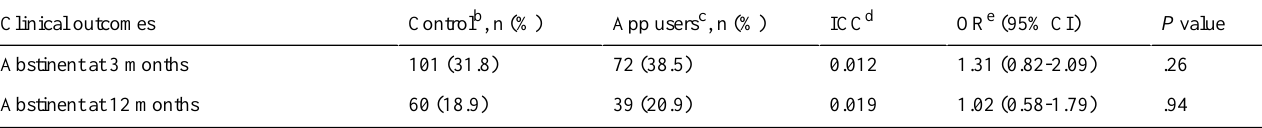
Table 3. Adjusted association in smoking cessation at 3 months and 12 months between control group and app users. a